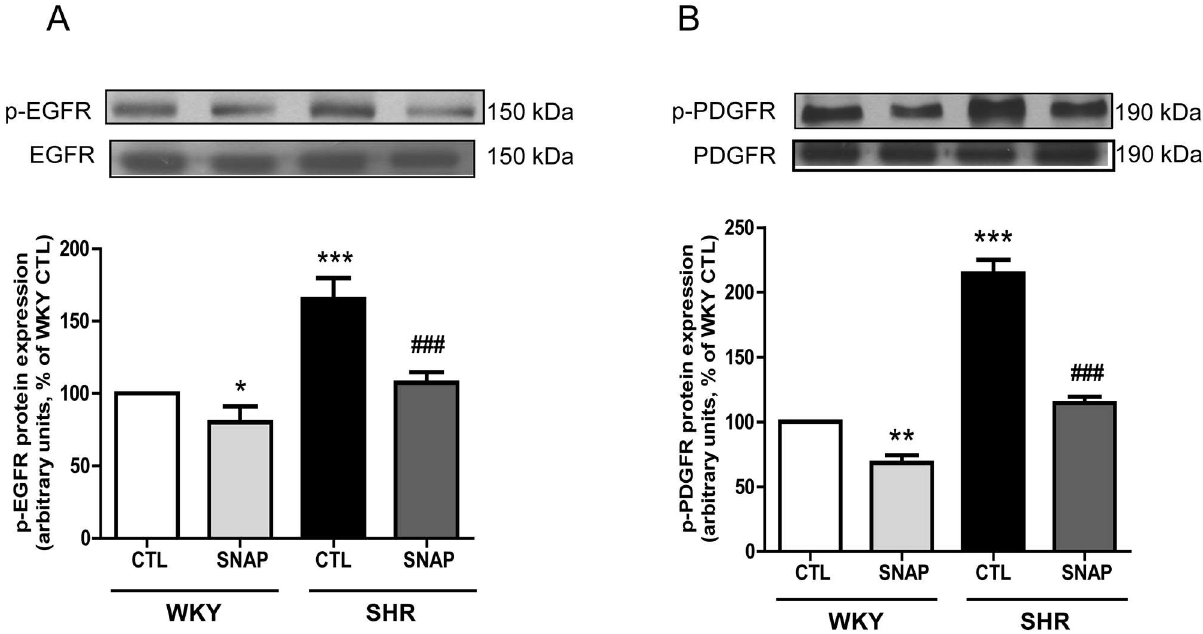
Fig 10. Effect of SNAP on EGFR phosphorylation and PDGFR phosphorylation protein levels in VSMC from 12-weekold SHR and age-matched WKY rats. ConfluentVSMC were incubatedin the absence(control) or presence of SNAP (100 μ M) for 24 h. The cell lysates were preparedand subjectedto Western blot analysisusing specific antibodiesagainstphosphorylated EGFR (A) or phosphorylated PDGFR (B, upper panels) as describedin the Materials and methods. Quantification of protein bandswas done by densitometric scanning (Lower panels). The results are expressedas a percentageof the WKY control (CTL), which was taken as 100%. Valuesare the mean ± SD of 6 separate experiments using different cell populationsfrom different animals. * P < 0.05, ** P < 0.01, *** P < 0.001vs WKY CTL group, ### P < 0.001vs SHR CTL